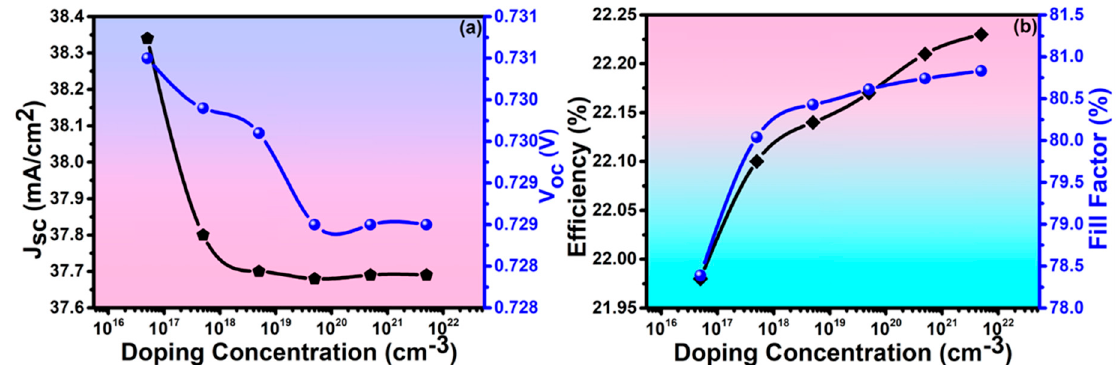
Figure 2. Impact of doping concentration on ( a ) short-circuit current density and open-circuit voltage, and ( b ) efficiency and fill factor for THE n-type region.